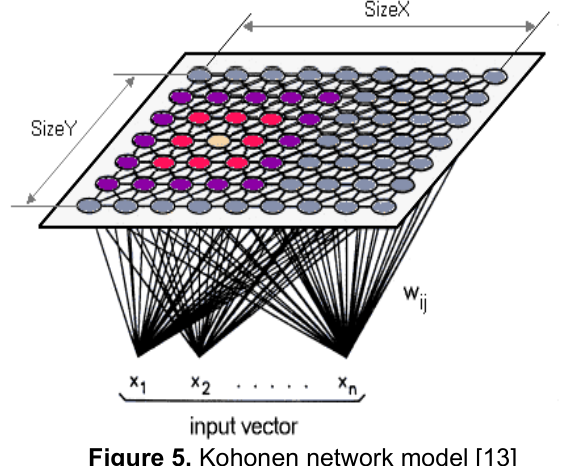
Figure 5. Kohonen network model